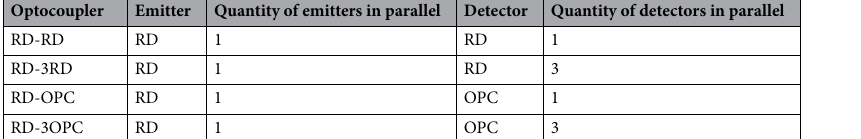
Table 5. Emitter and detector of fabriacted optocoupler